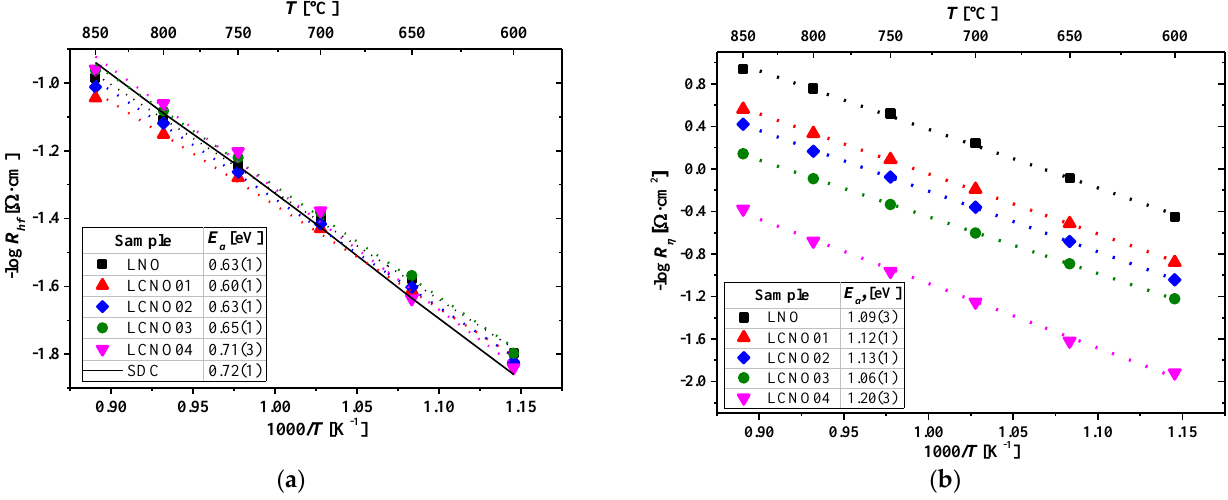
Figure 8. Temperature dependences of the reciprocal serial R hf ( a ) and polarization R η ( b ) resistance of the La 2−x Ca x NiO 4+δ electrodes in air.